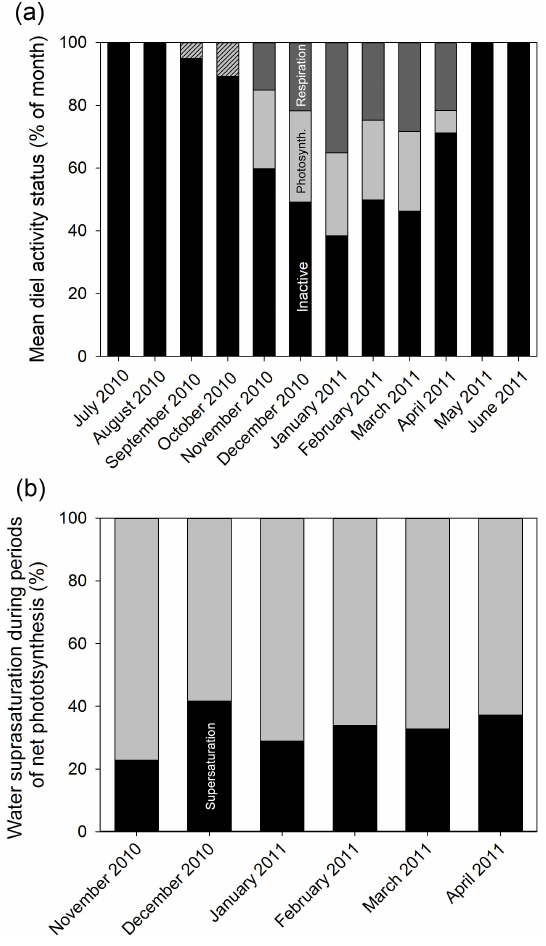
Figure 8. (a) Mean diel activity of the Boodjamulla biocrust: black means inactive; light grey means photosynthetically active; dark grey means dark respiration and hatched means metabolic activ- ity, but due to technical failure of instrumentation, unclear if NP or DR. (b) Monthly extent of water supersaturated periods during the photosynthetic (NP) active time of the Boodjamulla biocrust. Black means periods of supersaturation and light grey means periods of conducive water